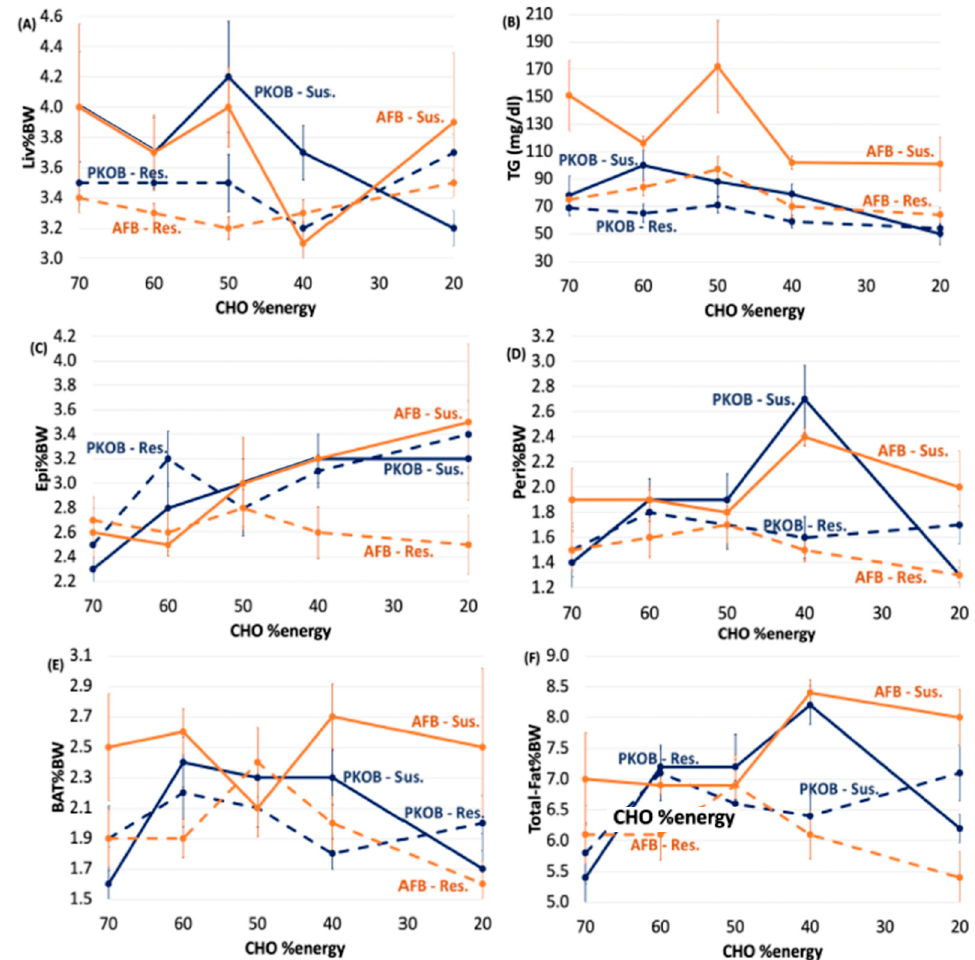
Figure 4. Differences in organ weights and plasma TG are depicted for rats that are resistant (dashed lines) and susceptible (solid lines) to diabetes. ( A ) Liver as %BW was greater in susceptible rats, and it was lowest at the highest fat intake where the least diabetes occurred. Liv%BW. ( B ) TG was greater in susceptible rats, especially those fed AFB, where increases at 70, 60 and 50 CHO %energy suggests a rising atherogenic risk associated with a lower 18:2(n-6) intake and P/S ratio of only 0.35 in the AFB. ( C ) Epididymal fat increased as the dietary CHO %energy decreased, and fat %energy increased, except for the AFB resistant rats, where it was greatly decreased by high fat. ( D ) Perirenal fat was the most energy-sensitive white adipose tissue. The spike in Peri%BW at the CHO:fat ratio of 40:40 %energy suggests that this white adipose tissue deposit may inversely reflect food intake by an undisclosed mechanism. For example, compare with Figure 3F, where all susceptible rats ate fewer BW-adjusted calories at 40% from CHO. ( E ) Brown Adipose Tissue (BAT) tended to be greater in susceptible rats fed AFB rats; BAT for both groups of susceptible rats generally was greater than that for comparable resistant rats. ( F ) Total fat reflected the perirenal fat response, i.e., susceptible rats in both groups had more total fat than the resistant rats, especially at 40% CHO %energy (see Tables S5 and S6 for details).